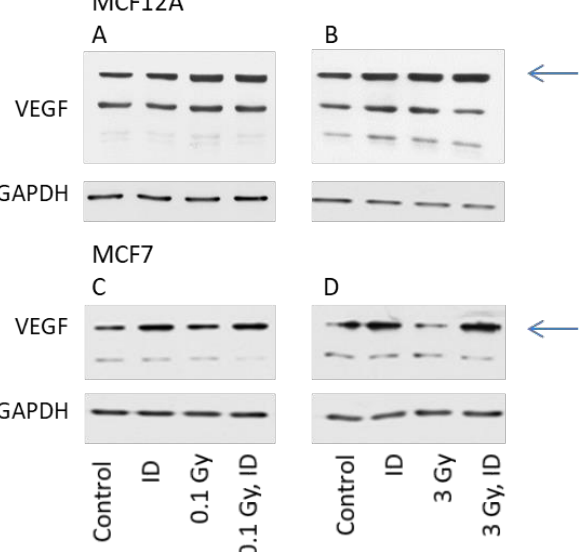
Figure 3. ID and radiation di ff erentially up-regulate VEGF protein in MCF12A and MCF7 breast cells. MCF12A ( A , B ) and MCF7 ( C , D ) cells were cultured in iodine-containing medium for 7 days. Thereafter, the medium was replaced by iodine-containing (control) or iodine deficient (ID) medium and cells were irradiated with a dose of 0.1 (A, C) or 3 Gy (B, D). Cells were harvested 5 (A, B) or 7 (C, D) hours after medium change. VEGF protein expression was visualized by western blot. N =